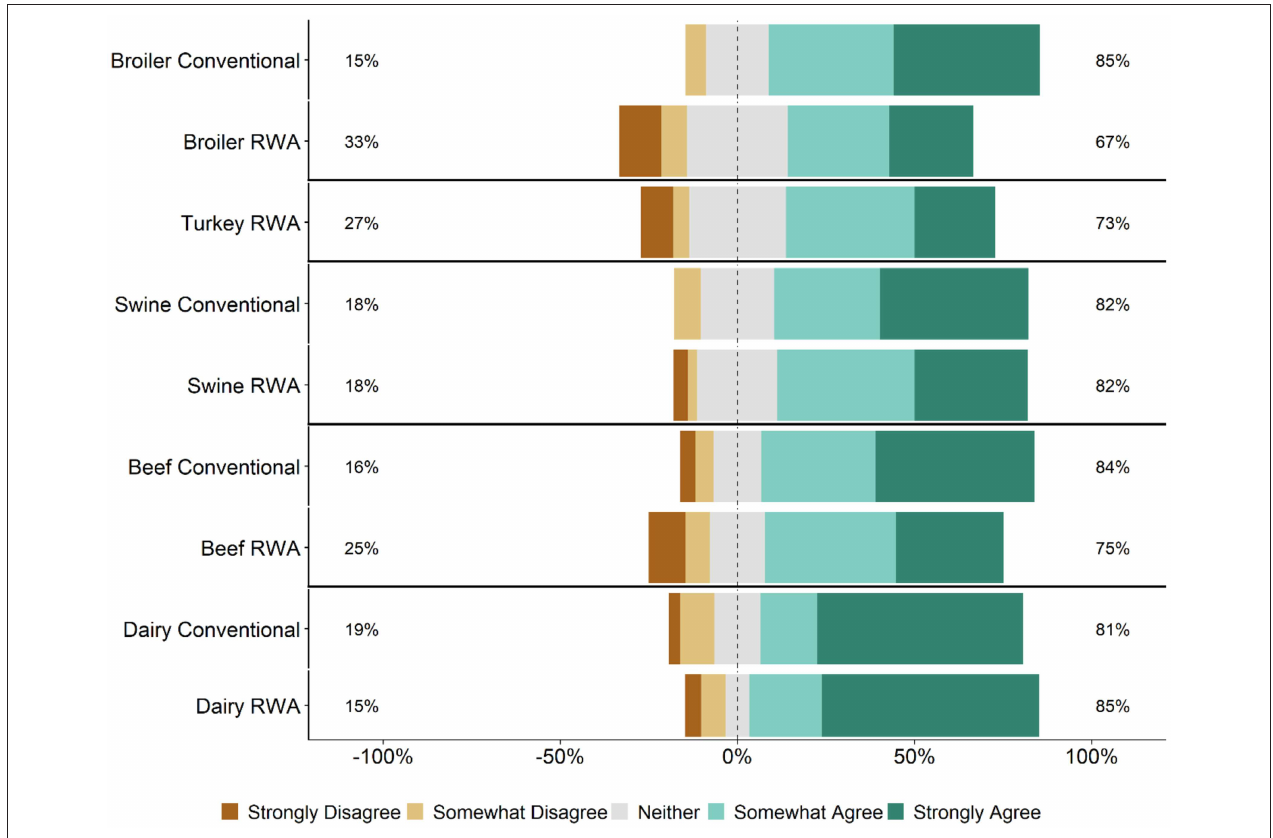
FIGURE 9 | Respondents’ opinion about the need for more stringent health and welfare auditing/assessment when animals are raised without antibiotics. Five-item Likert scale reporting respondents’ opinion, stratified by commodity and RWA